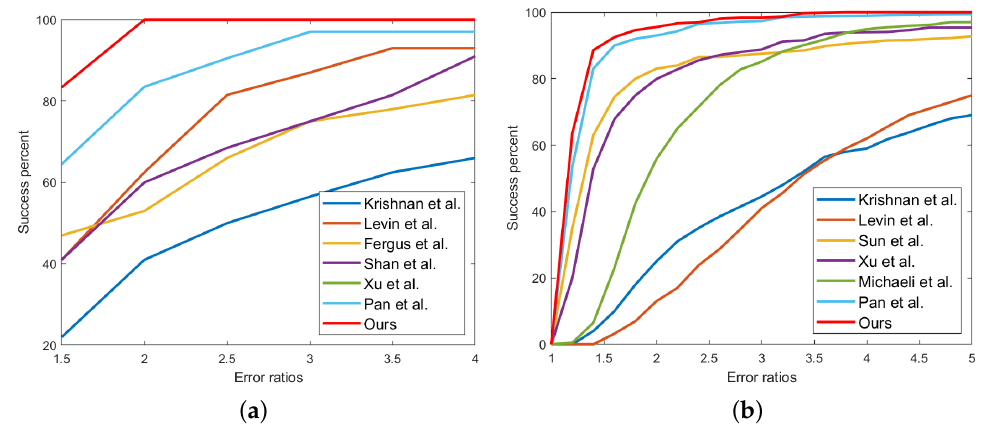
Figure 5. Quantitative results of our method on two benchmark datasets [12,22]: ( a ) error ratios com- parison between our approach and the other methods on the benchmark dataset [12]; ( b ) quantitative evaluations on the benchmark dataset [22].